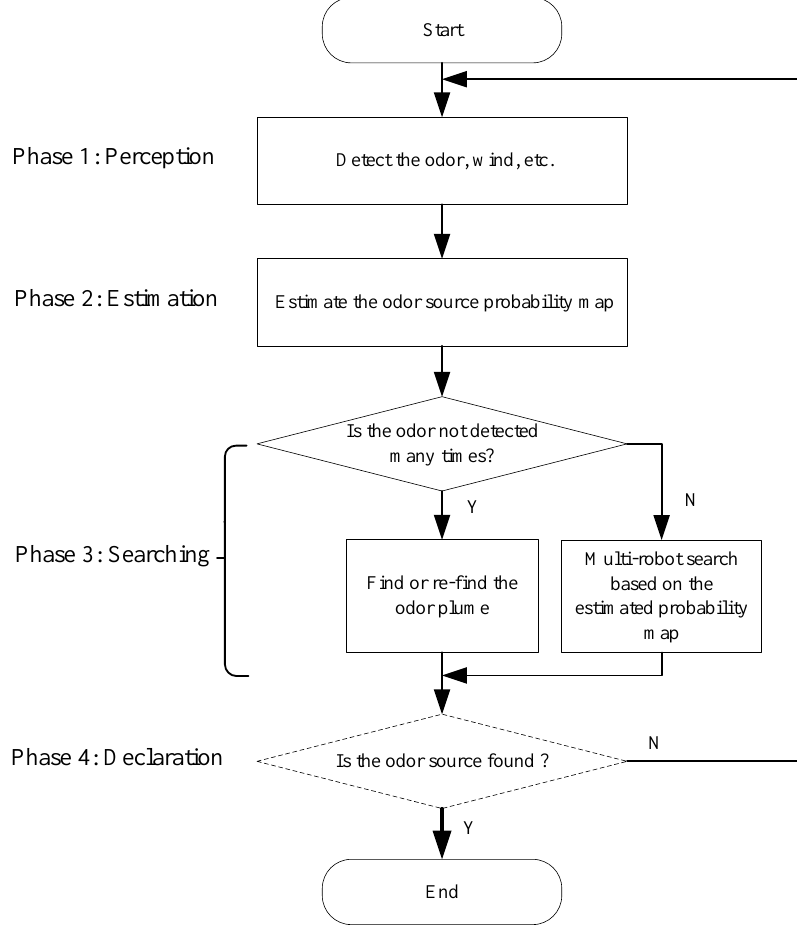
Detect the odor, wind, etc. Phase 1: Perception